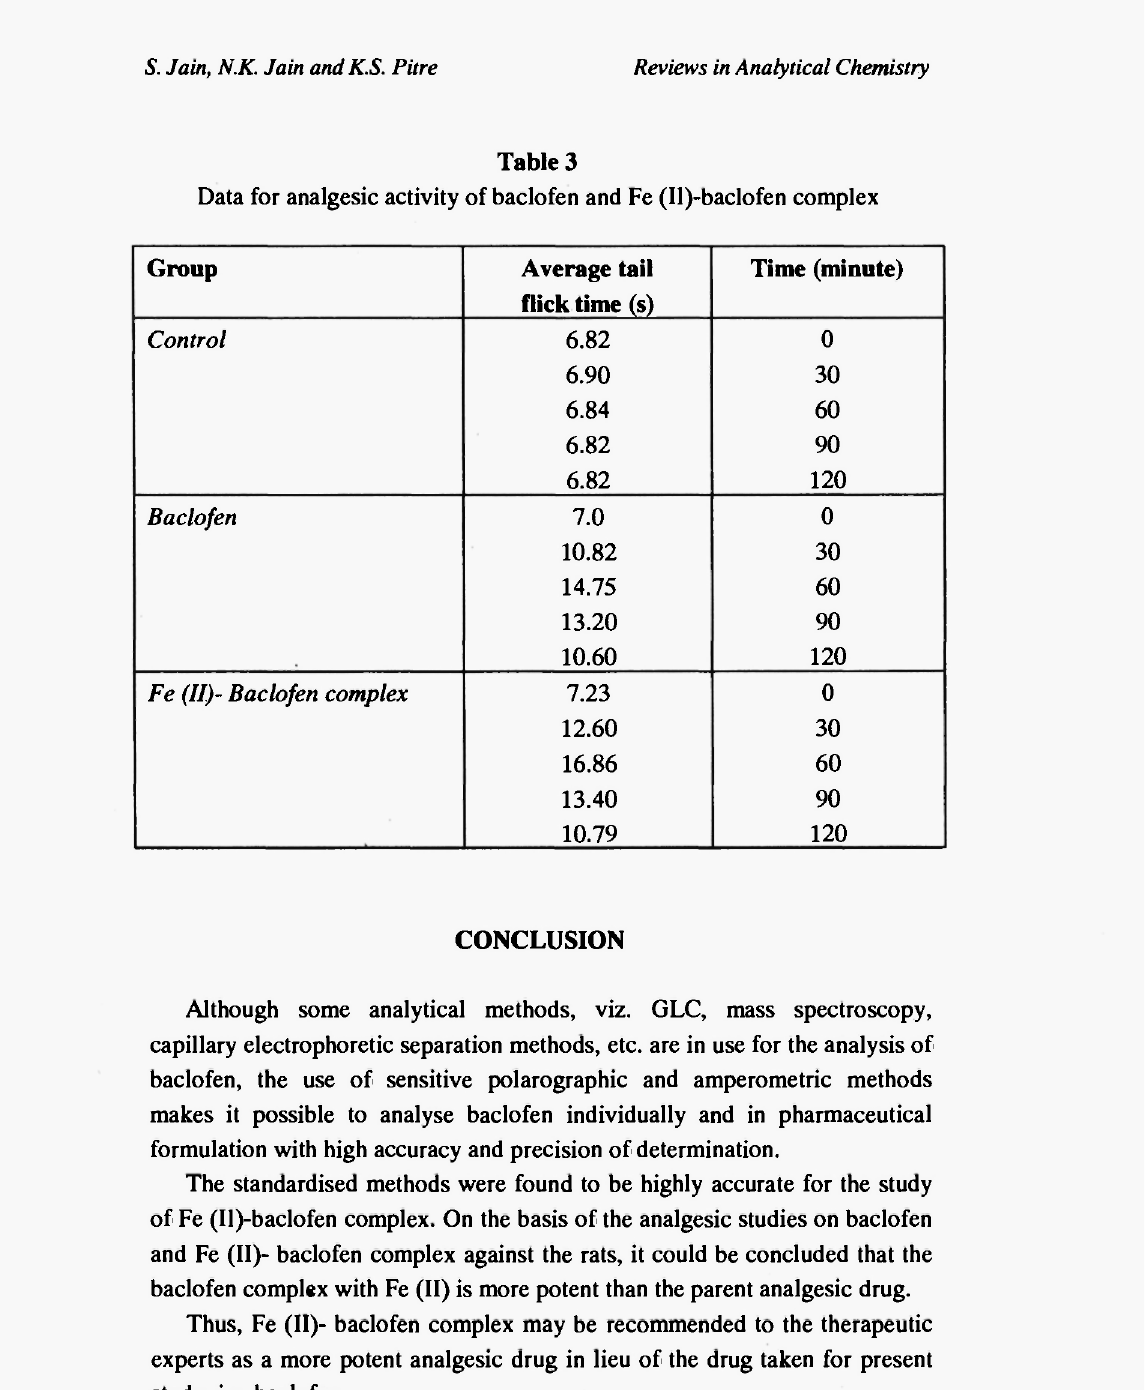
Data for analgesic activity of baclofen and Fe (Il)-baclofen complex